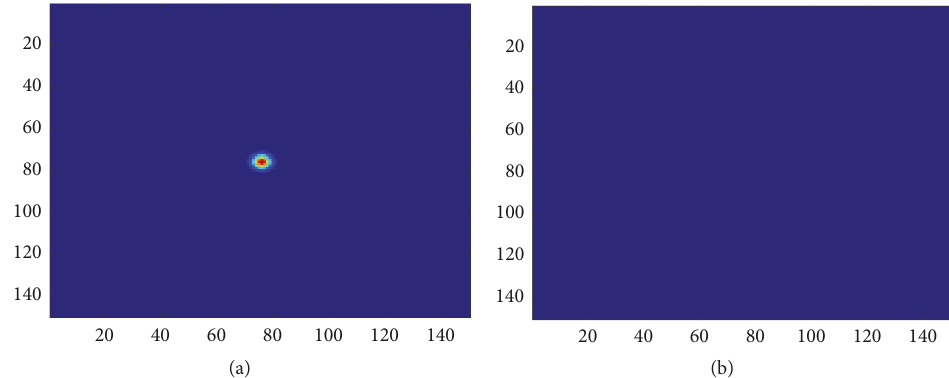
Figure 1: The snapshots of spatial distribution of membrane potential with color scale for neurons in the square array network for 𝑘 = 0 and 𝐷 = 1 at (a) 𝑡 = 2 time units and (b) 𝑡 = 6 time units.